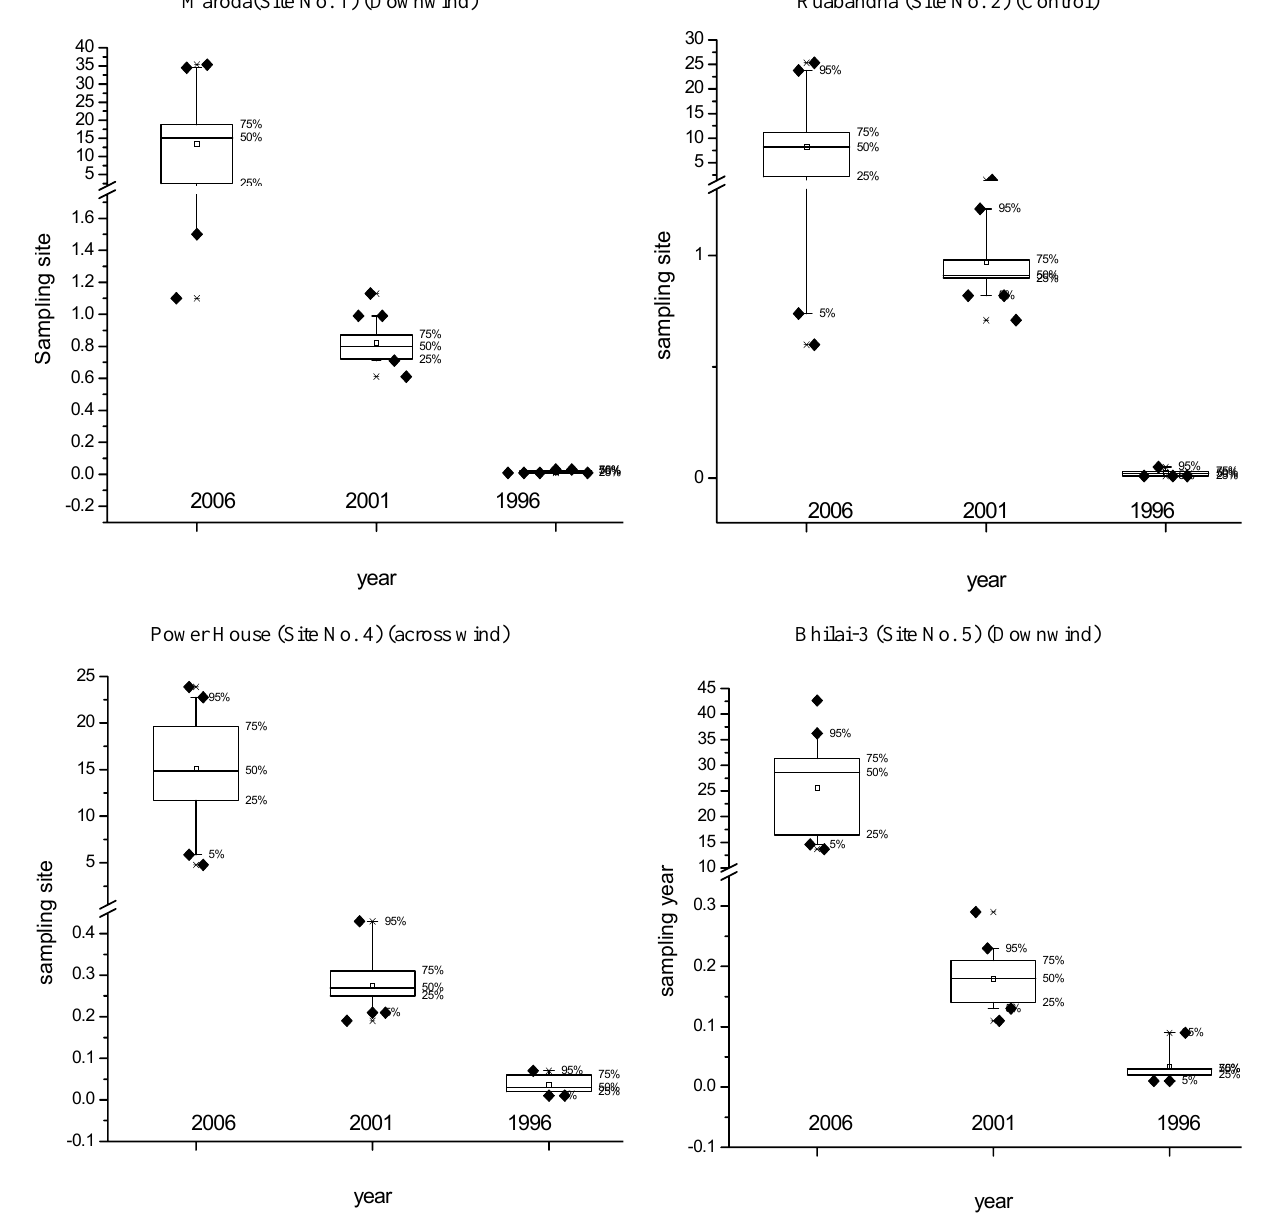
Fig. 5. Temporal variation of Total Ambient Hg in selected monitoring programs around Steel plant, Bhilai, India.